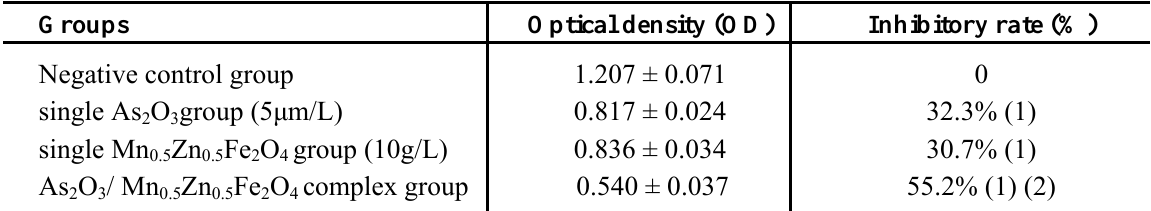
Table 2. Growth inhibitory rate of As HepG2